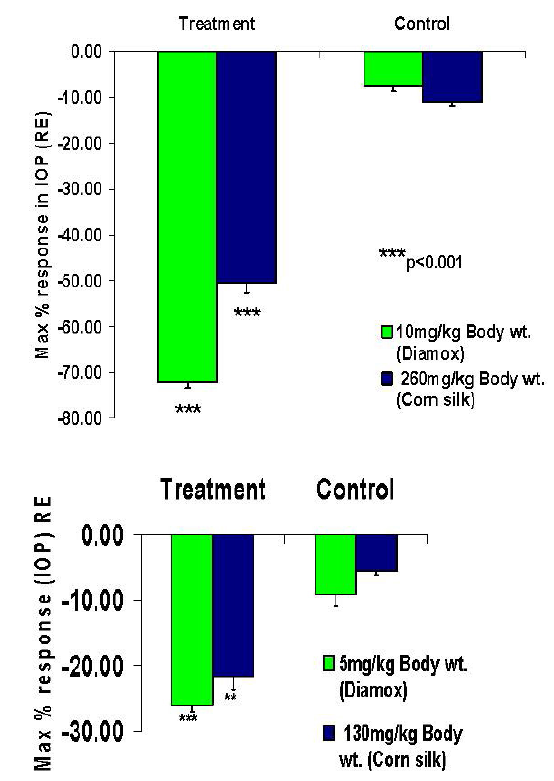
Figure 6 : Maximum percentage fall in mean IOP after administering (5 mg/kg and 10 mg/kg) acetazolamide and (130 mg/kg and 260 mg/kg) CSAE compared to water (control) in the right eye of ocular hypertensive subjects. Table 4 : Maximum % response of MABP after administering acetazolamide and CSAE to OHT